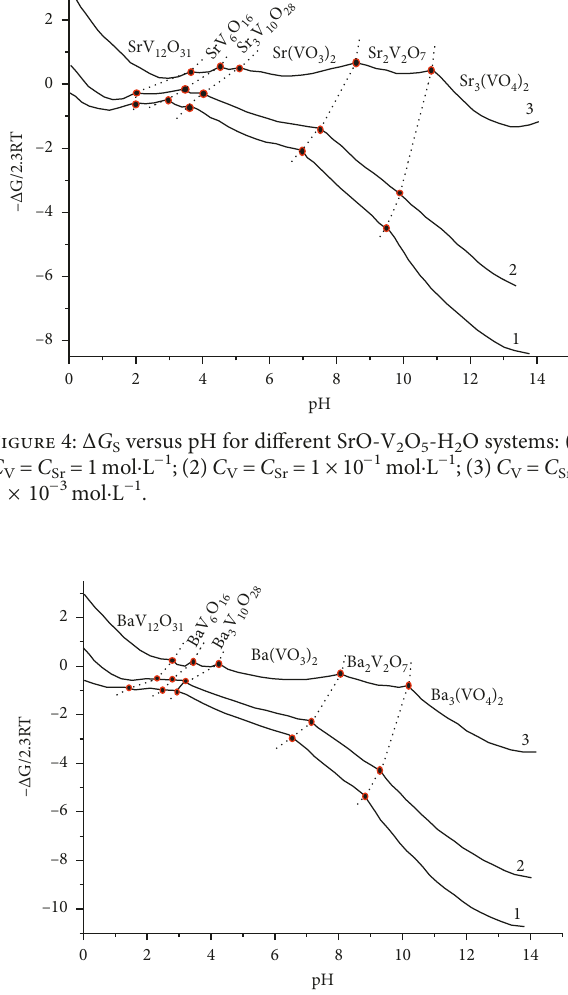
Figure 5: Δ G S versus pH for different BaO-V 2 O 5 -H 2 O systems: (1) C V � C Ba � 1mol · L − 1 ; (2) C V � C Ba � 1 × 10 − 1 mol · L − 1 ; (3) C V � C Ba � 1 × 10 − 3 mol · L − 1